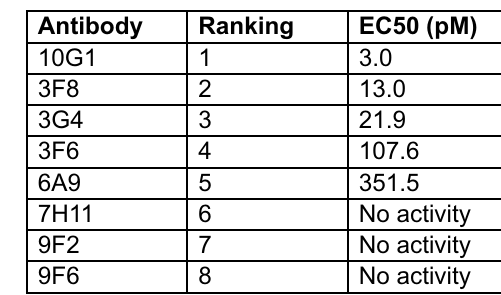
Figure 4. Antibody dependant cellular cytotoxicity activities of anti-RON antibodies tested in